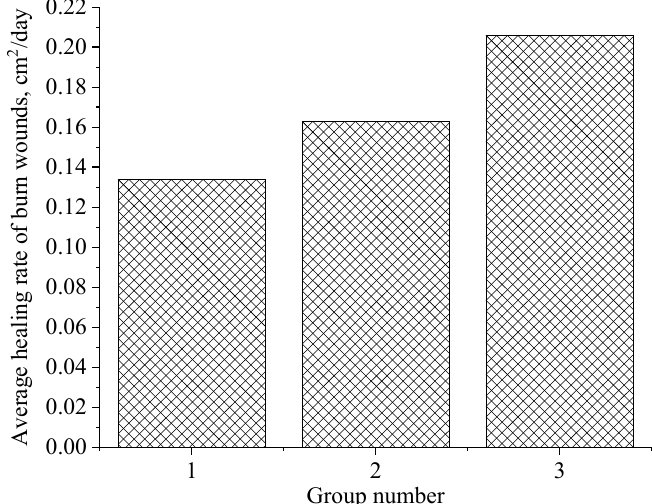
Figure 14. The average rate of healing of burn wounds over the entire experimental period in animals: 1—hydroxyethylcellulose gel; 2—gel of ZnO MPs and hydroxyethylcellulose; 3—gel of ZnO NPs modified with hydroxyethylcellulose.